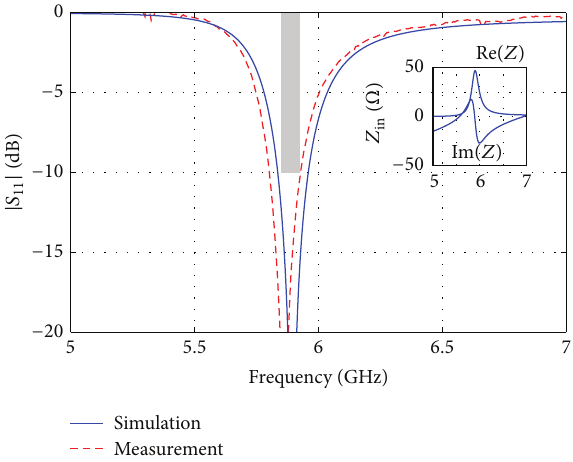
Figure 9: Simulated and measured reflection coefficient of the antenna. The simulated input impedance is given in an